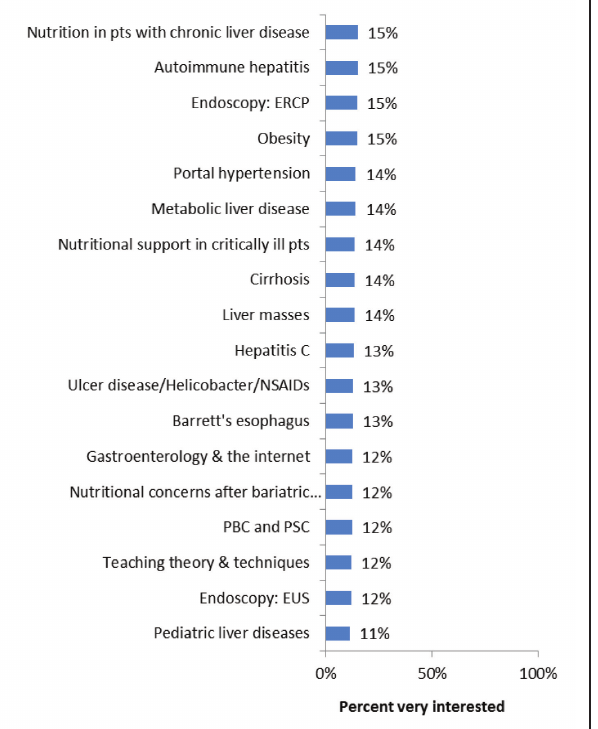
Figure 3) Educational topics in which 11% to 15% of respondents were